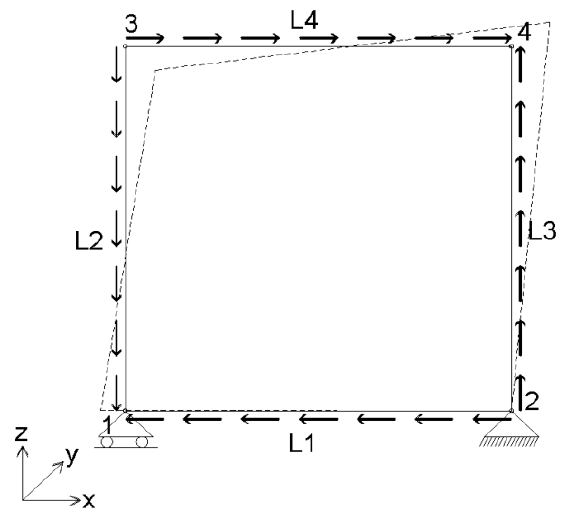
Figure 12. In-plane shear loading using line loads